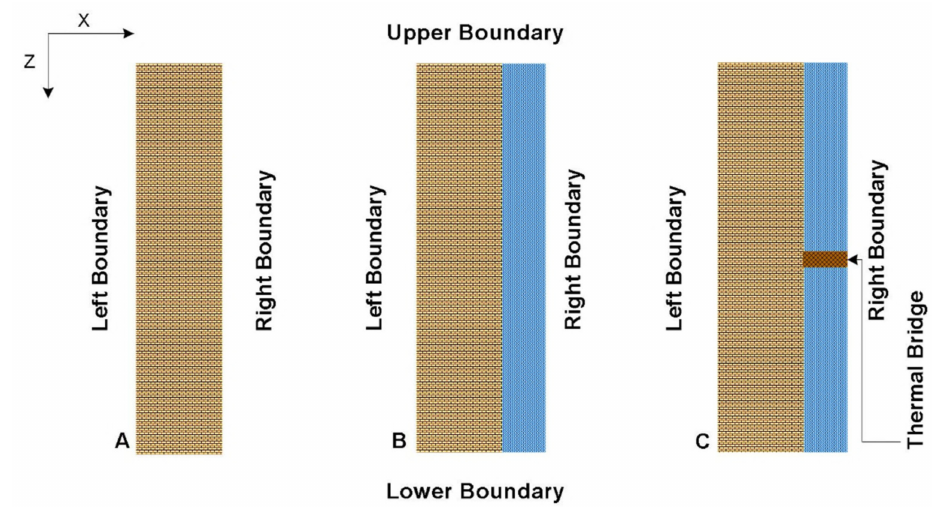
Figure 5. ( A ) One-layer wall, ( B ) wall with insulator, and ( C ) wall with insulator and thermal